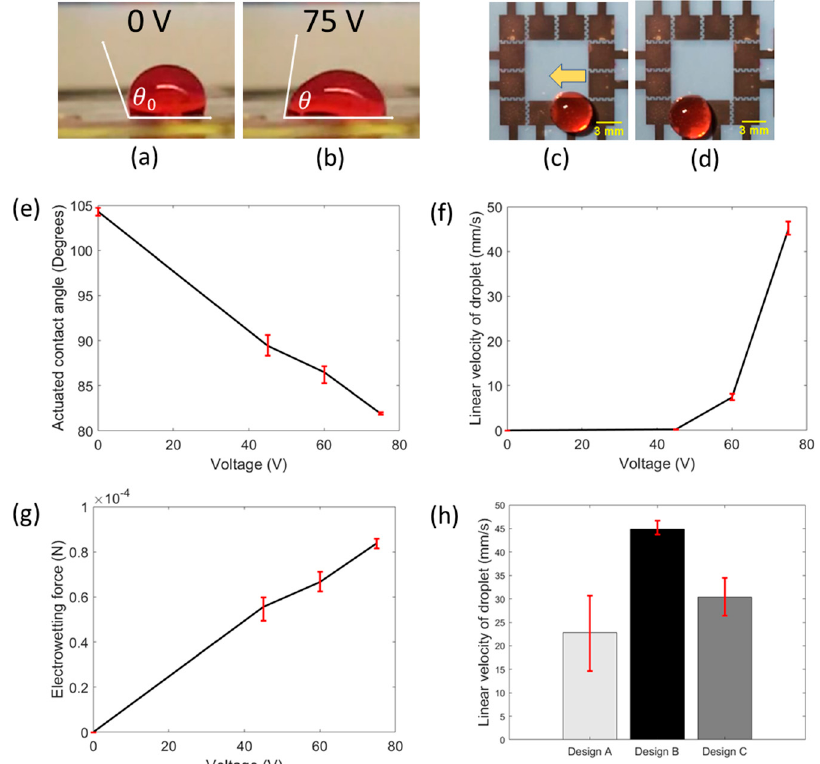
Figure 2. ( a ) Side view of the droplet with zero voltage as taken by a smartphone camera. The contact angle of the droplet is greater than 90 ◦ because of the underlying hydrophobic coating. ( b ) Side view of the droplet at an actuation voltage of 75 V as taken by a smartphone camera. The contact angle decreases due to the decrease in the solid–liquid surface tension. ( c ) Image showing a droplet placed on the FINP-DMF platform. ( d ) When the adjacent electrode is actuated, the droplet moves towards the actuated electrode. ( e ) Graph showing the variation of actuated contact angle with actuation voltage. ( f ) Graph showing variation of linear droplet velocity with the actuation voltage. ( g ) Graph showing the variation of calculated electrowetting force with the actuation voltage. ( h ) Bar graph showing the linear droplet velocity on electrode designs A, B and C.